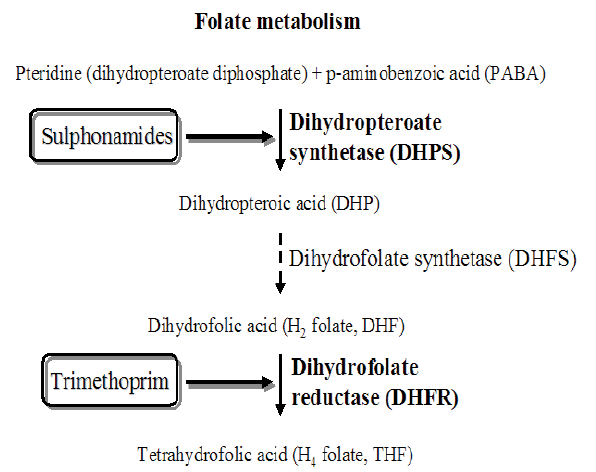
Figure 7. Sulphonamides and trimethoprim inhibit distinct steps in folate